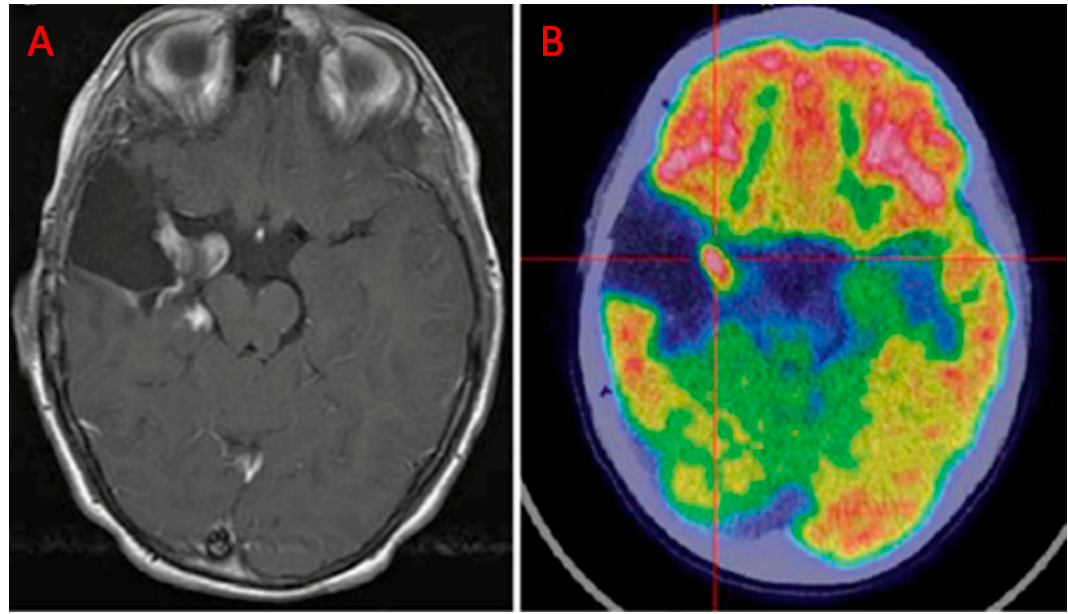
Figure 3. Patient with anaplastic astrocytoma, resected 2 years before, treated with temozolomide. ( A ) T1-w MRI signal alteration in the right amygdala and posterior part of the para-hippocampus. ( B ) 18 F- FDG-avid finding, suggestive for disease recurrence (Courtesy of Dr. Cistaro).